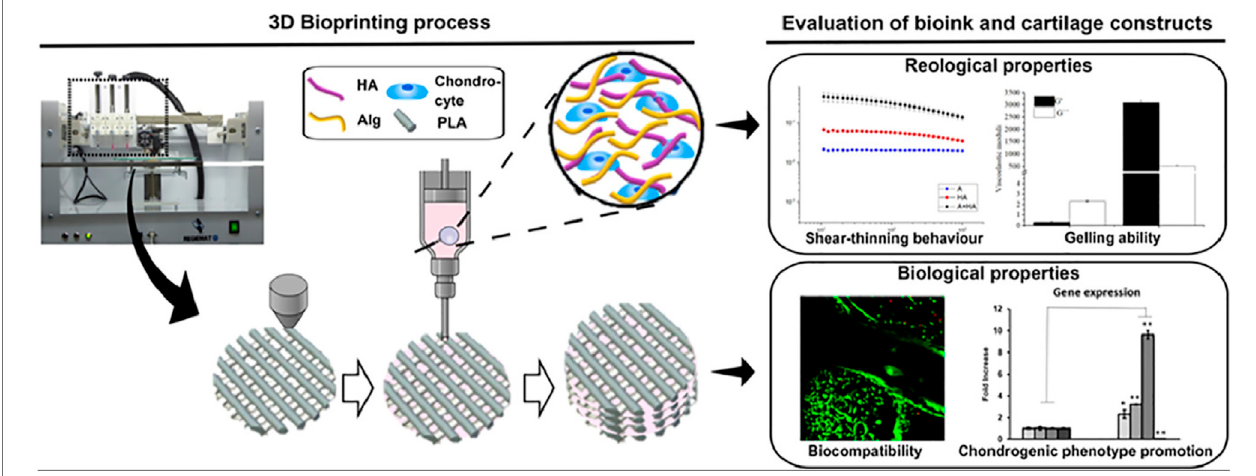
FIGURE 3 | A new composite hydrogel material for the 3D printing of articular cartilage repair (Antich et al., 2020) (Reproduced from Creative Commons license).